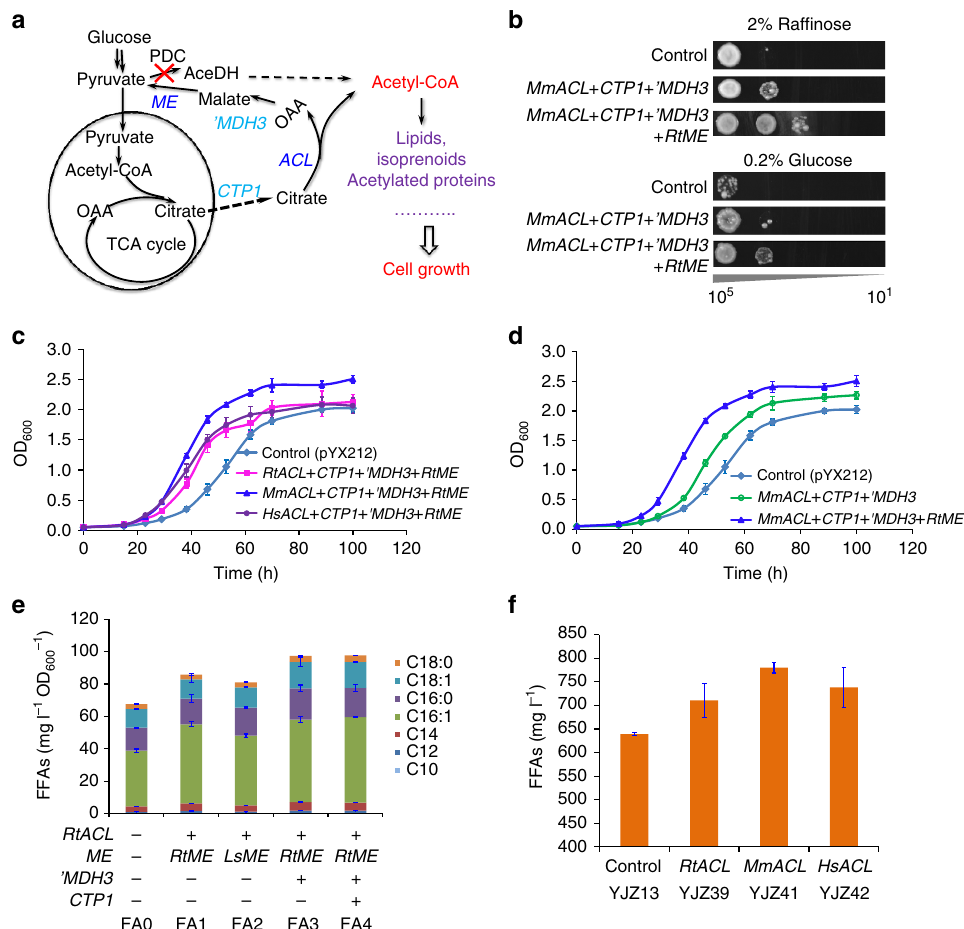
Figure 3 | Optimization and characterization of ACL-based acetyl-CoA pathways in S. cerevisiae . ( a ) Schematic illustration of the chimeric citrate lyase pathway for improved supply of acetyl-CoA, a key precursor for synthesis of cell building block. ( b ) The ACL-based acetyl-CoA pathway rescued the growth of PDC-negative strain RWB837, which is growth-deficient. ( c ) Introduction of the ACL-based acetyl-CoA pathway improved the growth of PDC-negative mutant strain S. cerevisiae IMI076. Cells were cultured with an initial OD 600 of 0.05 in SC-URA at 30 (cid:2) C, 200r.p.m. ( d ) ME is beneficial for cell growth in addiction to ACL in the PDC-negative mutant strain S. cerevisiae IMI076. ( e ) Introduction of the heterologous citrate lyase by-pass pathway improved FFA production. The engineered strains were constructed by transforming YJZ08 with the corresponding plasmids as shown in Supplementary Table 3. ( f ) Effect of different ACLs on production of FFAs. RtACL , MmACL and HsACL represent the optimized ACL genes from R. toruloides , M. musculus and H. sapiens , respectively. The engineered strains were cultivated in shake flasks containing 15ml minimal media for 72h at 200r.p.m., 30 (cid:2) C. All data represent the mean ± s.d. of biological triplicates.